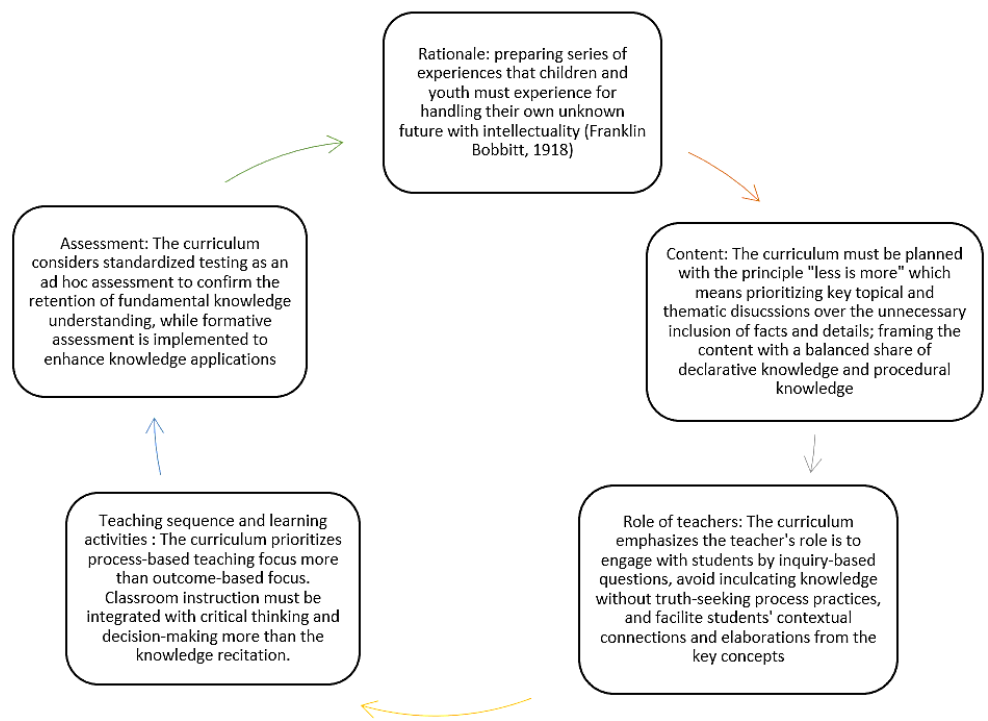
Figure 6. Principles for developing a knowledge-rich curriculum with an orientation towards deep knowledge